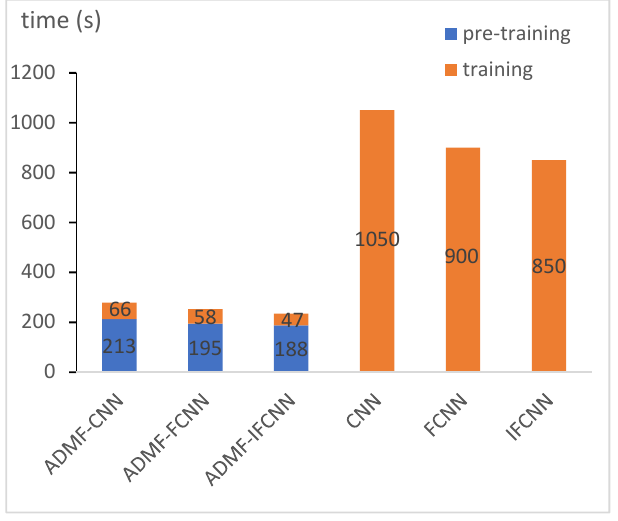
Figure 12. The total time consumption of the pre-training and training process.